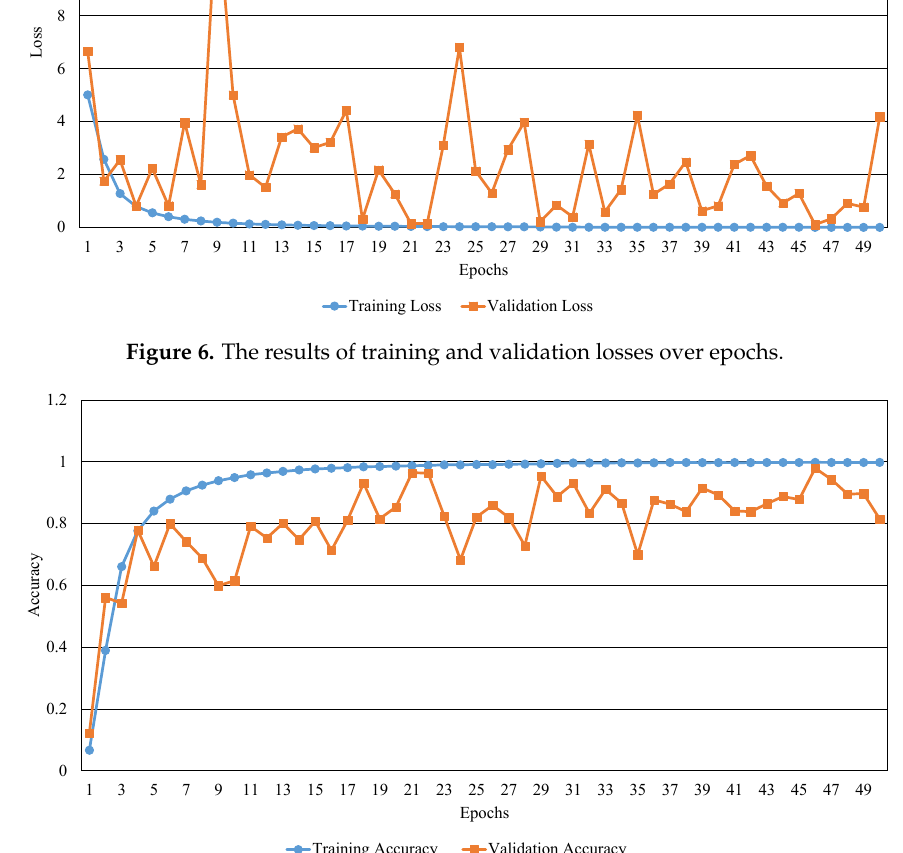
Figure 7. The results of training and validation accuracies over